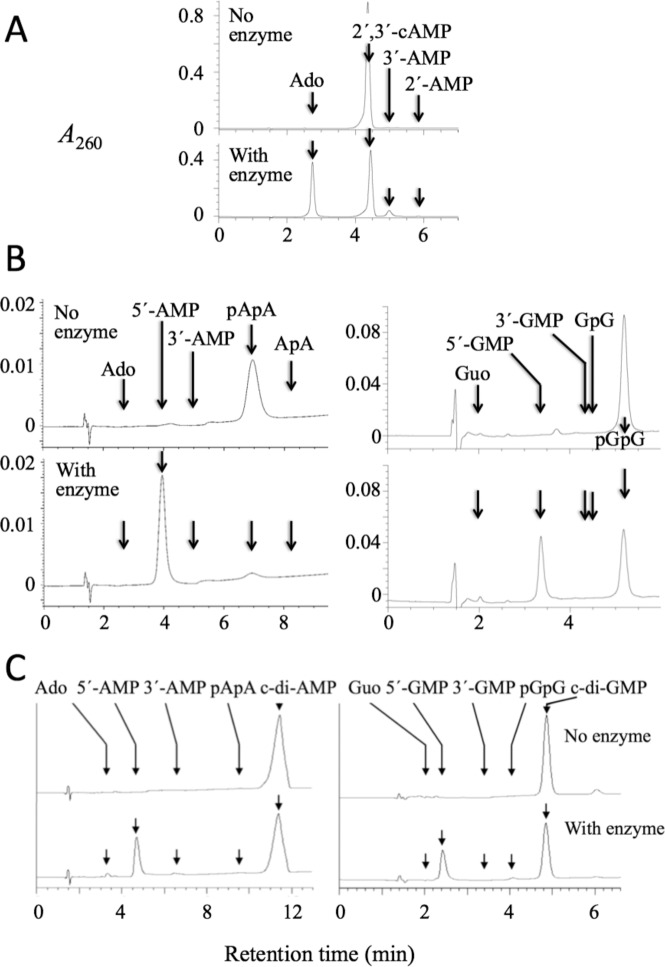
Reaction products of recombinant CpdB by HPLC.All the incubations were performed at 37°C. (A) Hydrolysis of 500 μM 2´,3´-cAMP by 0.23 μg ml-1 of CpdB in a 12-min incubation. (B) Hydrolysis of (left panels) 10 μM pApA by 1.5 μg ml-1 of CpdB in a 4-min incubation, or (right panels) 5 μM pGpG by 1 μg ml-1 of CpdB in a 20-min incubation. (C) Hydrolysis of (left panels) 20 μM c-di-AMP by 0.3 μg ml-1 of CpdB in a 15-min incubation, or (right panels) 20 μM c-di-GMP by 15 μg ml-1 of CpdB in an 8-min incubation.